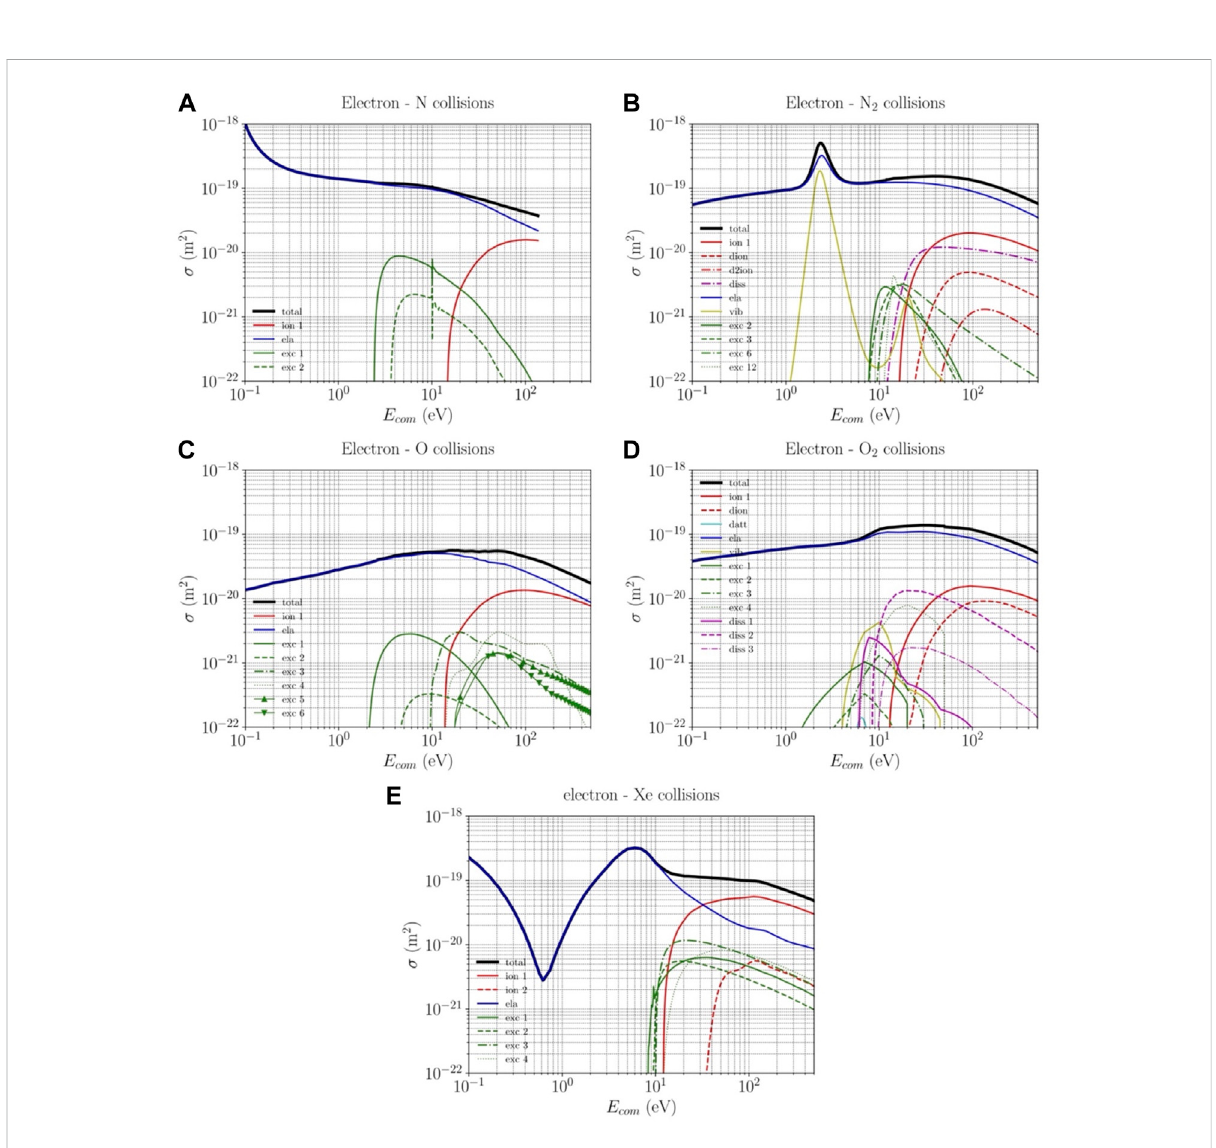
FIGURE 5 Electron-neutral collision cross-sections used in the model for (A) atomic nitrogen N, (B) molecular nitrogen N 2 , (C) atomic oxygen, (D) molecular oxygen O 2 , and (E)